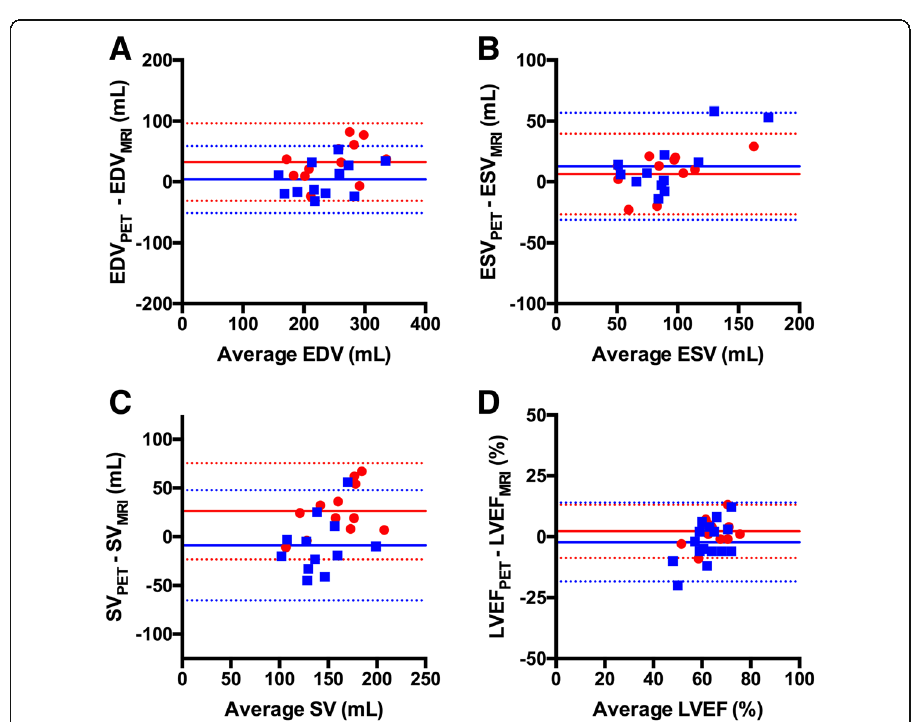
Fig. 4 Bland Altman plots between 15 O-water PET volume-based method and MRI ESV ( a ), EDV ( b ), SV ( c ) and LVEF ( d ). Circles (red) are values from V B images, and squares (blue) are values from FP images. Solid lines are the mean difference, and dashed lines are the limits of agreement. Outliers were